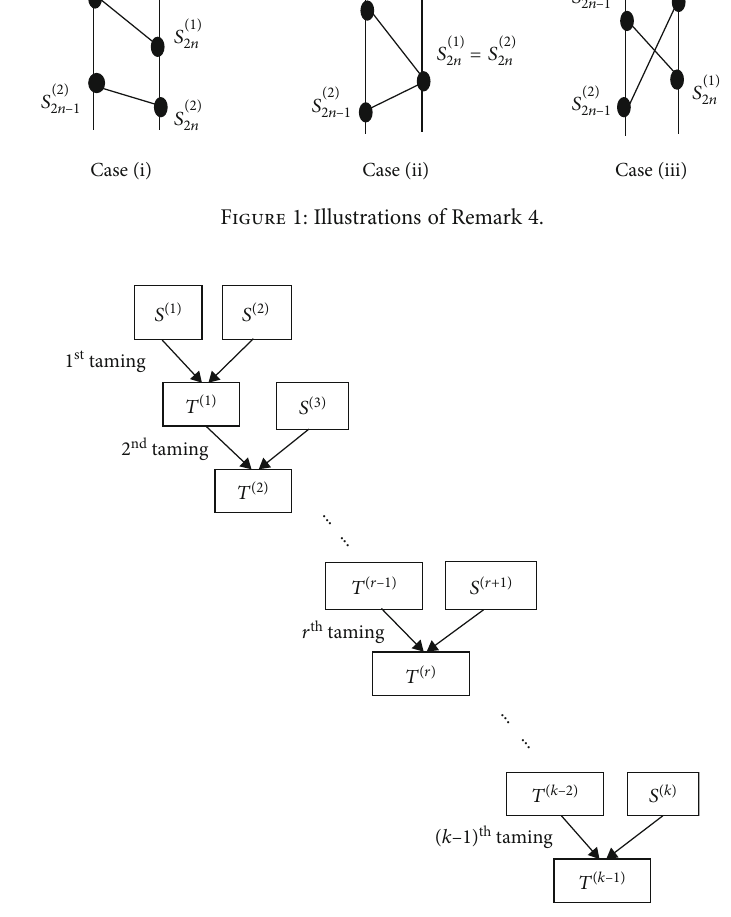
Figure 2: Taming k number of time